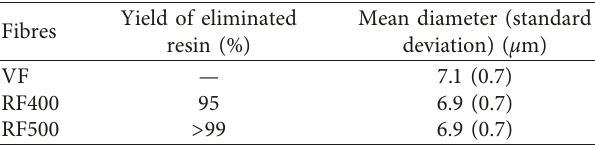
Table 2: Studied samples and associated steam-thermolysis ex- perimental conditions.